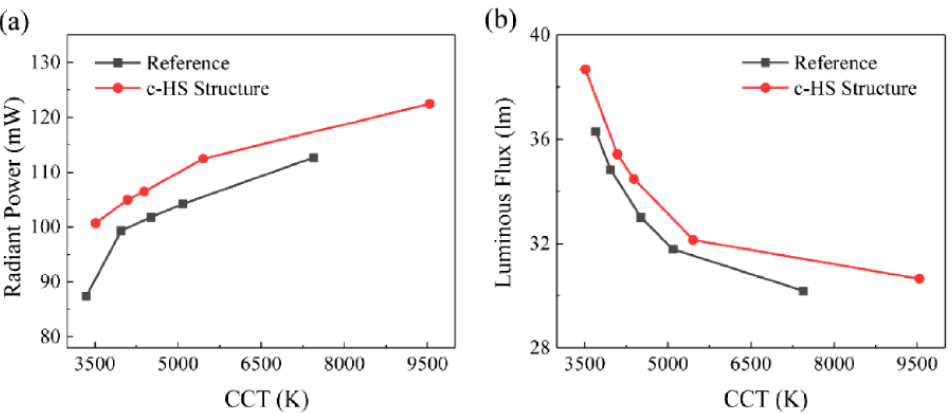
Figure 9. ( a ) Radiant power and ( b ) luminous flux of the reference structure and c-HS structure at different correlated color temperature (CCT) values [64]. Figure reproduced with permission from Optical Society of America.